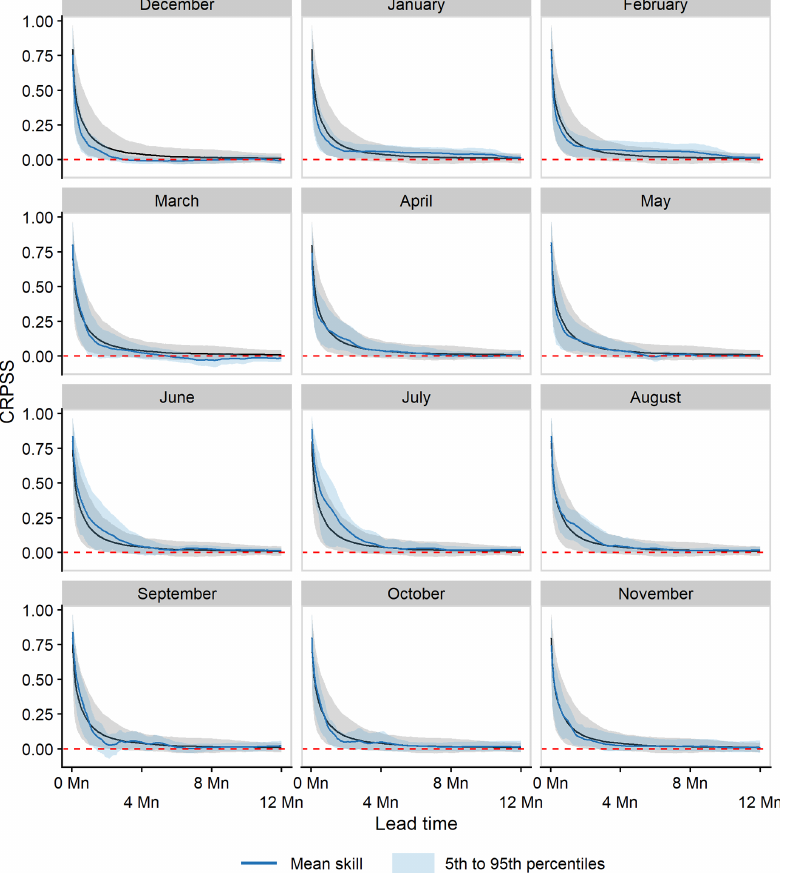
parametric Spearman rank correlation coefficient ( ρ ).